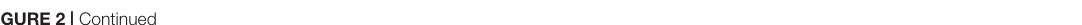
( Figure 2E , p -value = 1.71e-93; Supplementary Table S3 ; Lee C. S. et al., 2017), and 38 of 112 CEBP-1 target genes (Kim et